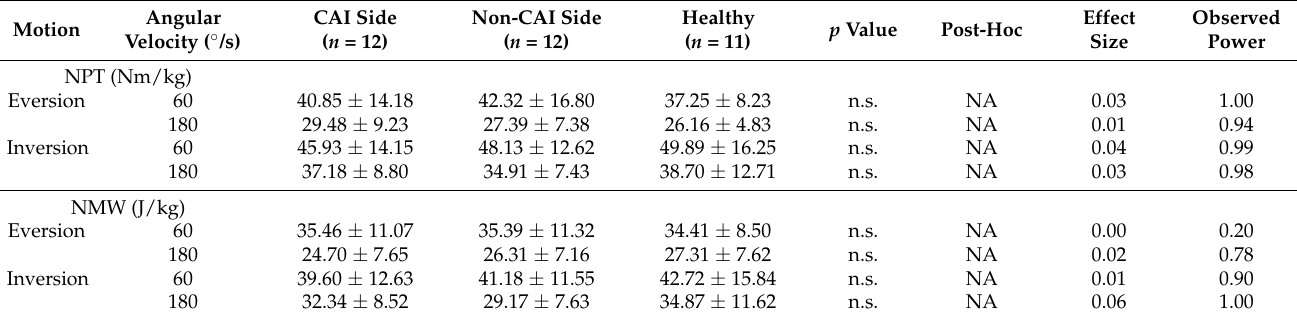
Table 2. Comparison of evertor and invertor mean normalized peak torques and the mean normalized maximum work done at 60 ◦ /s and 180 ◦ /s between the CAI and healthy groups of